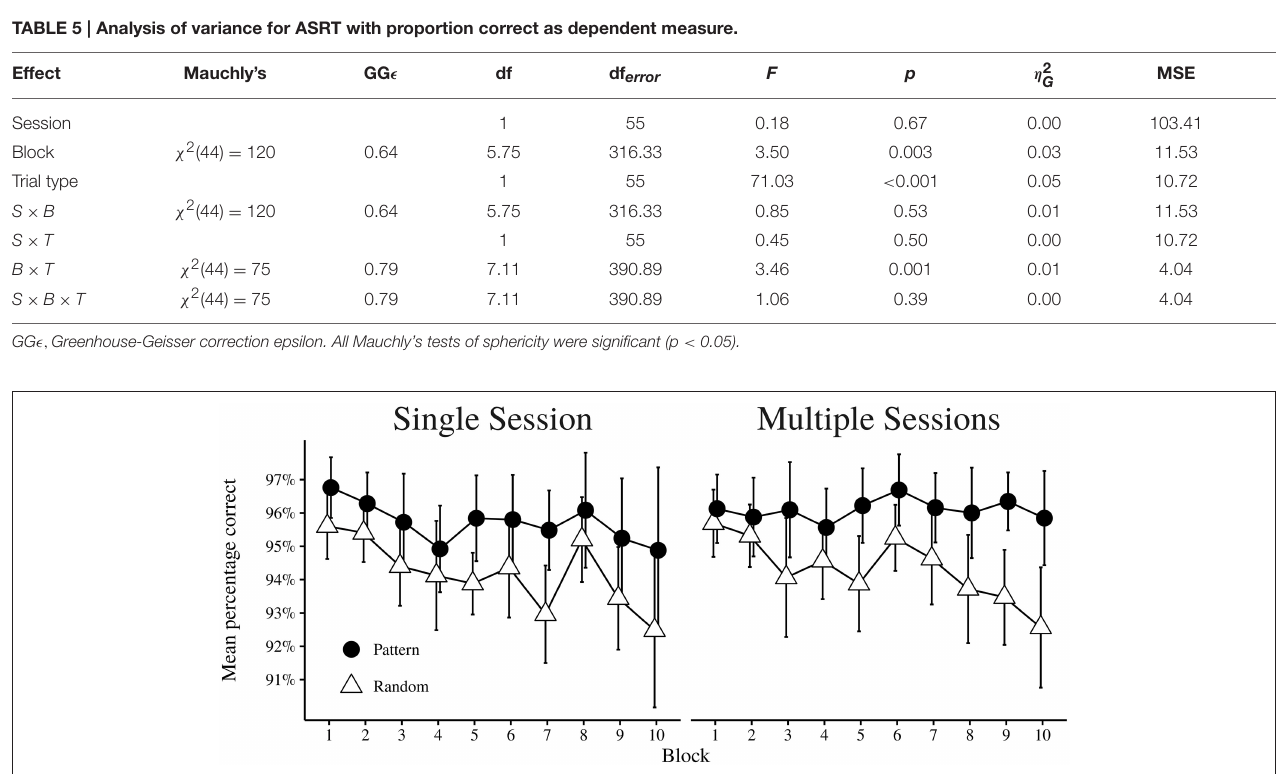
expected by random input (all p ’s < 0.01). For an